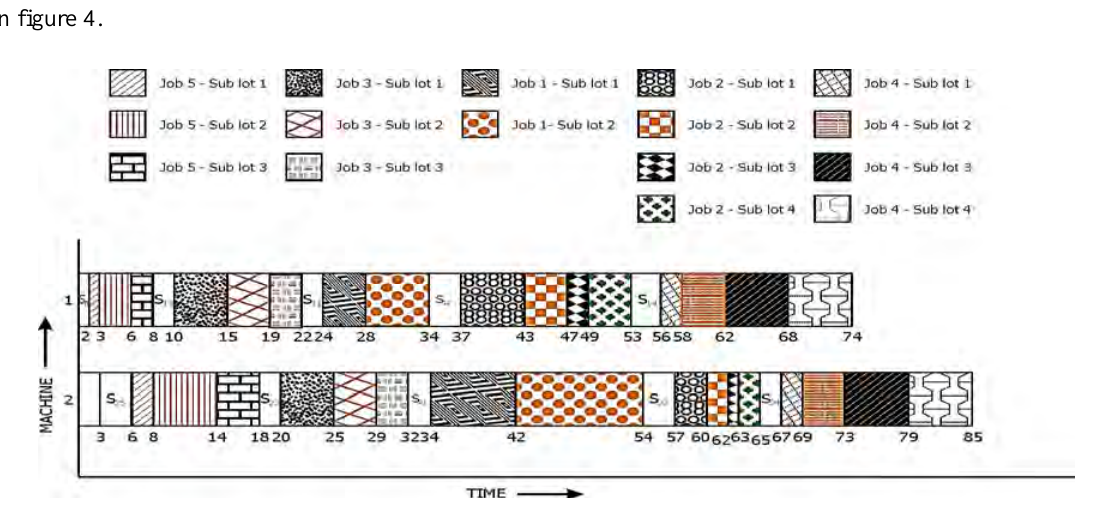
Fig.4 - Schedule for the sequence